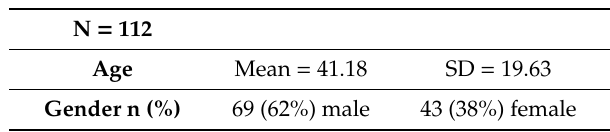
Table 2. Demographic data.